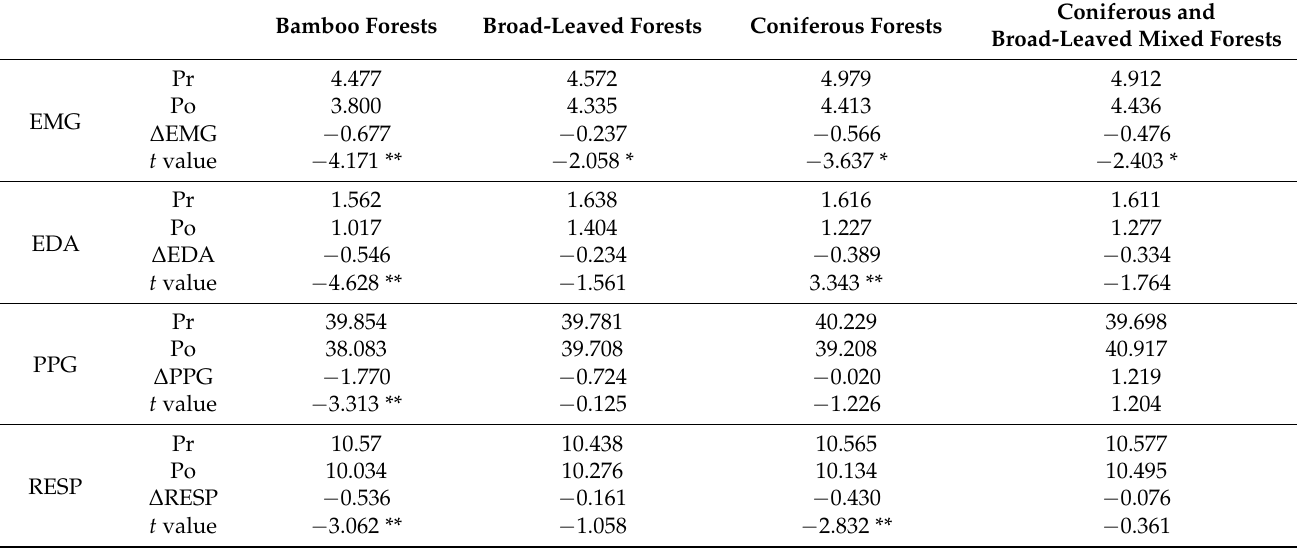
Table 3. The t -test of EMG, EDA, PPG, and RESP at pre-test and post-test in different forest